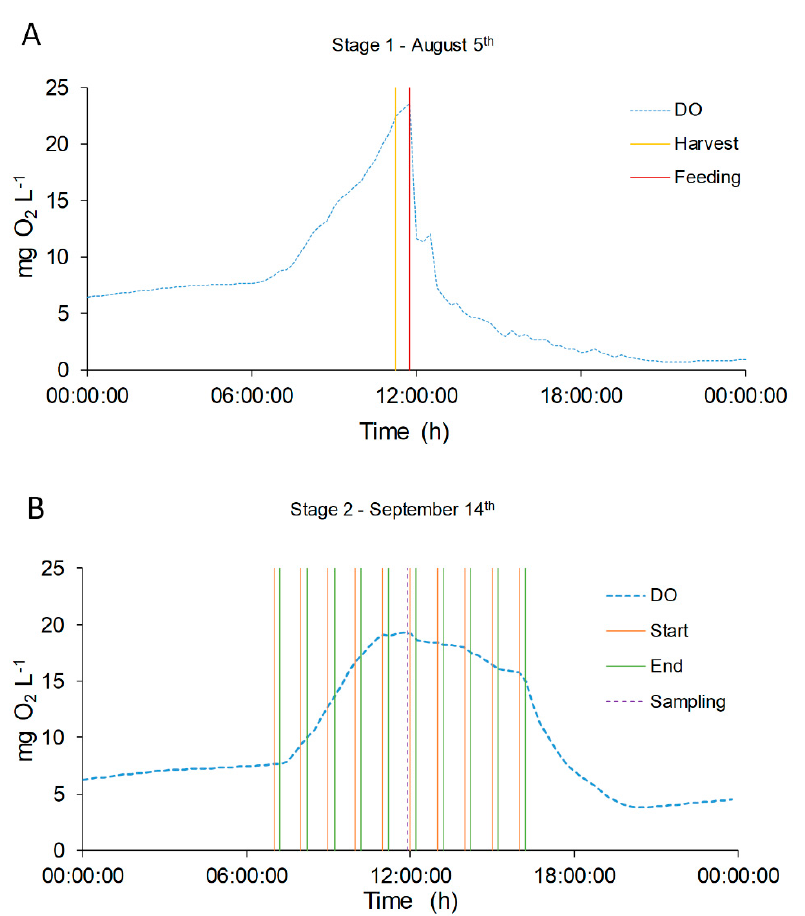
Figure 8. DO concentration evolution in two single days, representative of the two feeding modes: August 5th ( A ) and September 14th ( B ). DO concentration is represented with green dotted line ( ●●● ) . In Graphic ( A ) the yellow line ( ̶ ) represents the harvest time and red line ( ̶ ) the feeding time. In Graphic ( B ) the orange line ( ̶ ) represents the start feeding time and the green one ( ̶ ) the end feeding. The violet dotted line ( ●●● ) represents the sampling time.